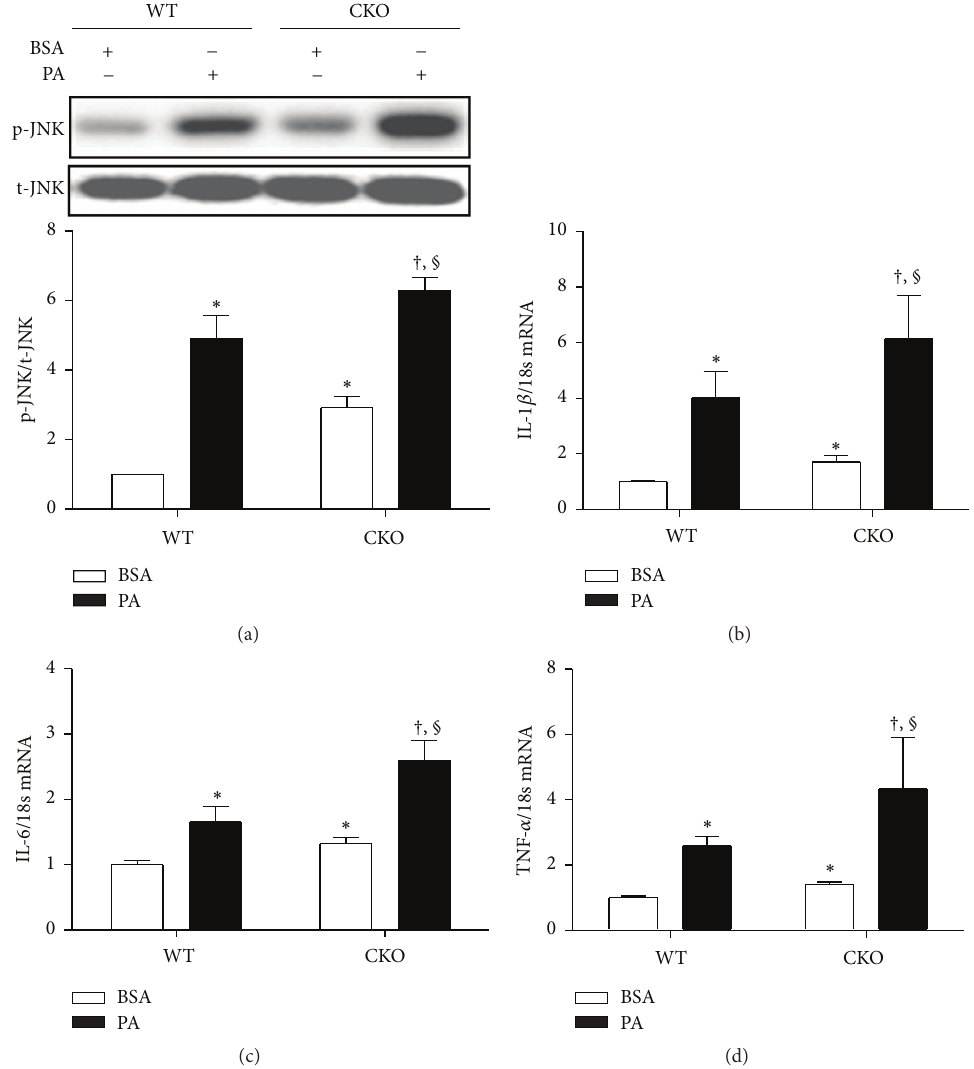
Figure 4: Catalase knockdown increases palmitate-induced inflammation in bone marrow-derived macrophages. Bone marrow-derived macrophages from WT and CKO mice were treated with 500 𝜇 M PA for 6h, using BSA as control. (a) JNK phosphorylation was measured by western blot (upper panel) and densitometry (lower panel). (b) IL-1 𝛽 , (c) IL-6, and (d) TNF- 𝛼 mRNA expression was measured by real-time PCR. Data are mean ± SE of four experiments. ∗ 𝑝 < 0.05 versus WT macrophages exposed to BSA; † 𝑝 < 0.05 versus CKO macrophages exposed to BSA; § 𝑝 < 0.05 versus WT macrophages exposed to